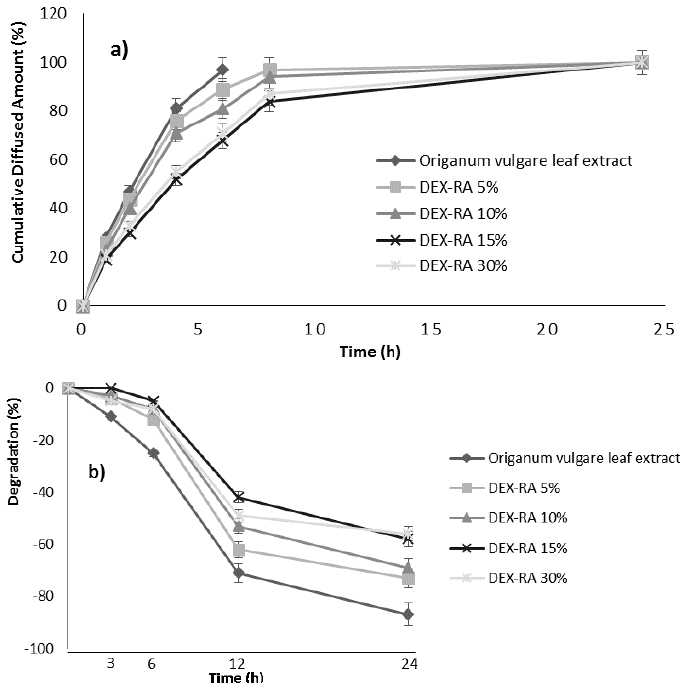
Figure 1. ( a ) In vitro diffusion profiles; and ( b ) stability studies: degradation percentages.